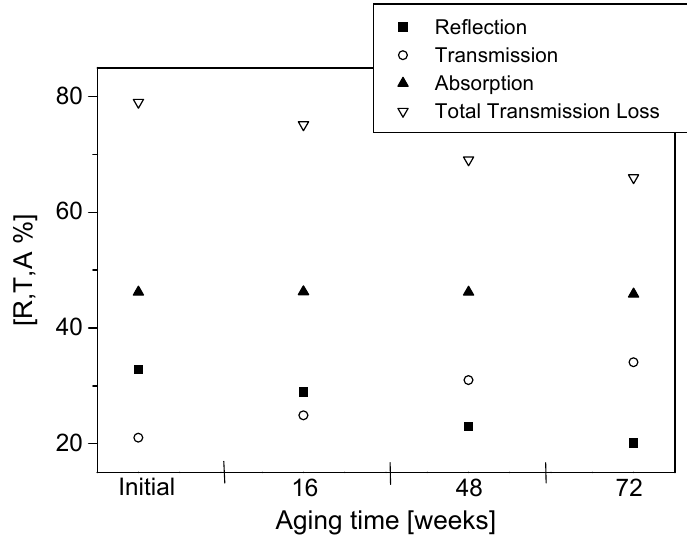
Figure 12. Reflection, transmission, absorption and total transmission loss for PPy- p TSA–coated Nylon-Lycra. Polymerisation time: 180 min, p TSA concentration: 0.027 mol/L.